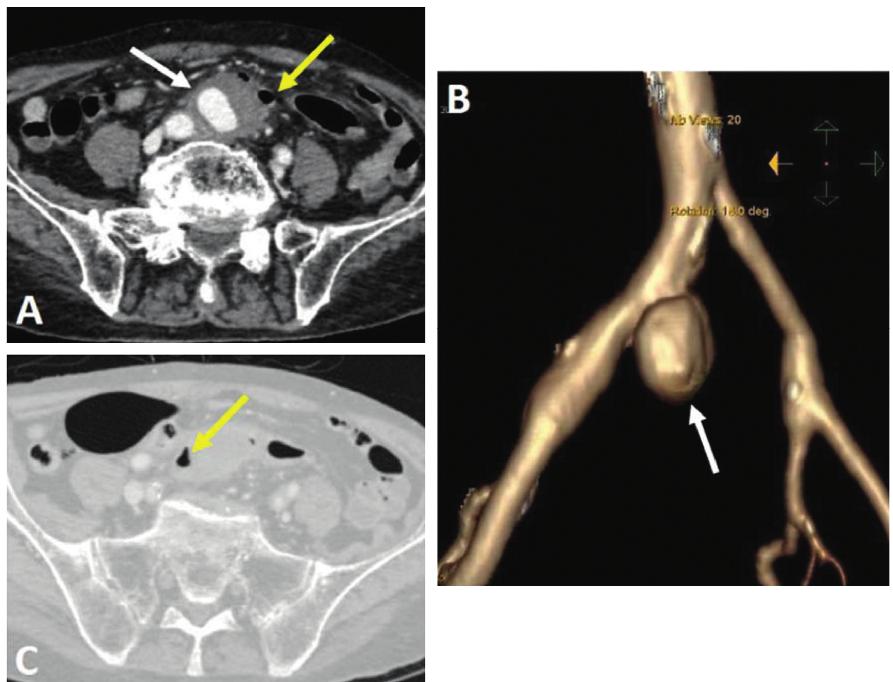
Figure 2: CT scanner at the time of admission. (a, b) Enhanced axial and reconstruction coronal CT shows a 31 × 36 × 40mm saccular aneurysm (arrows) arising from the right common iliac artery and prominent inflammatory soft tissue around the aneurysm. The anterior wall of the aneurysm has adhered to the posterior wall of the sigmoid colon ((a), yellow arrow). Gas foci ((c), yellow arrow) were noted around the